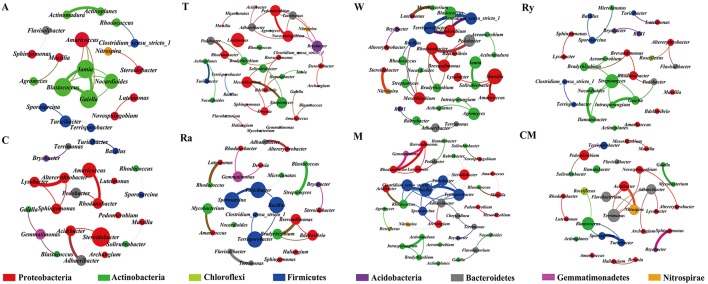
Network of co-occurring bacterial genera based on correlation analysis for intercropping cultivations and cucumber monoculture. A connection stands for a strong (Spearman's ρ > 0.6) and significant (P < 0.01) correlation. The size of each node is proportional to the degree, the thickness of each edge is proportional to the value of Spearman's correlation coefficients. Nodes colored by taxonomy.